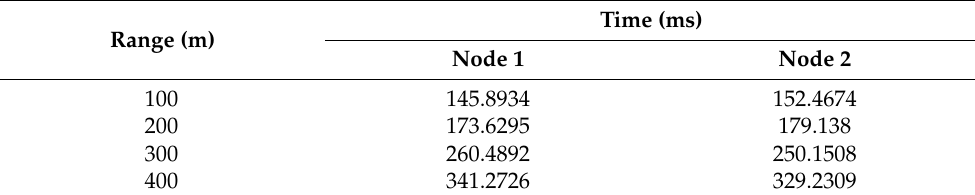
Table 4. The average value from reassessment of default parameters.